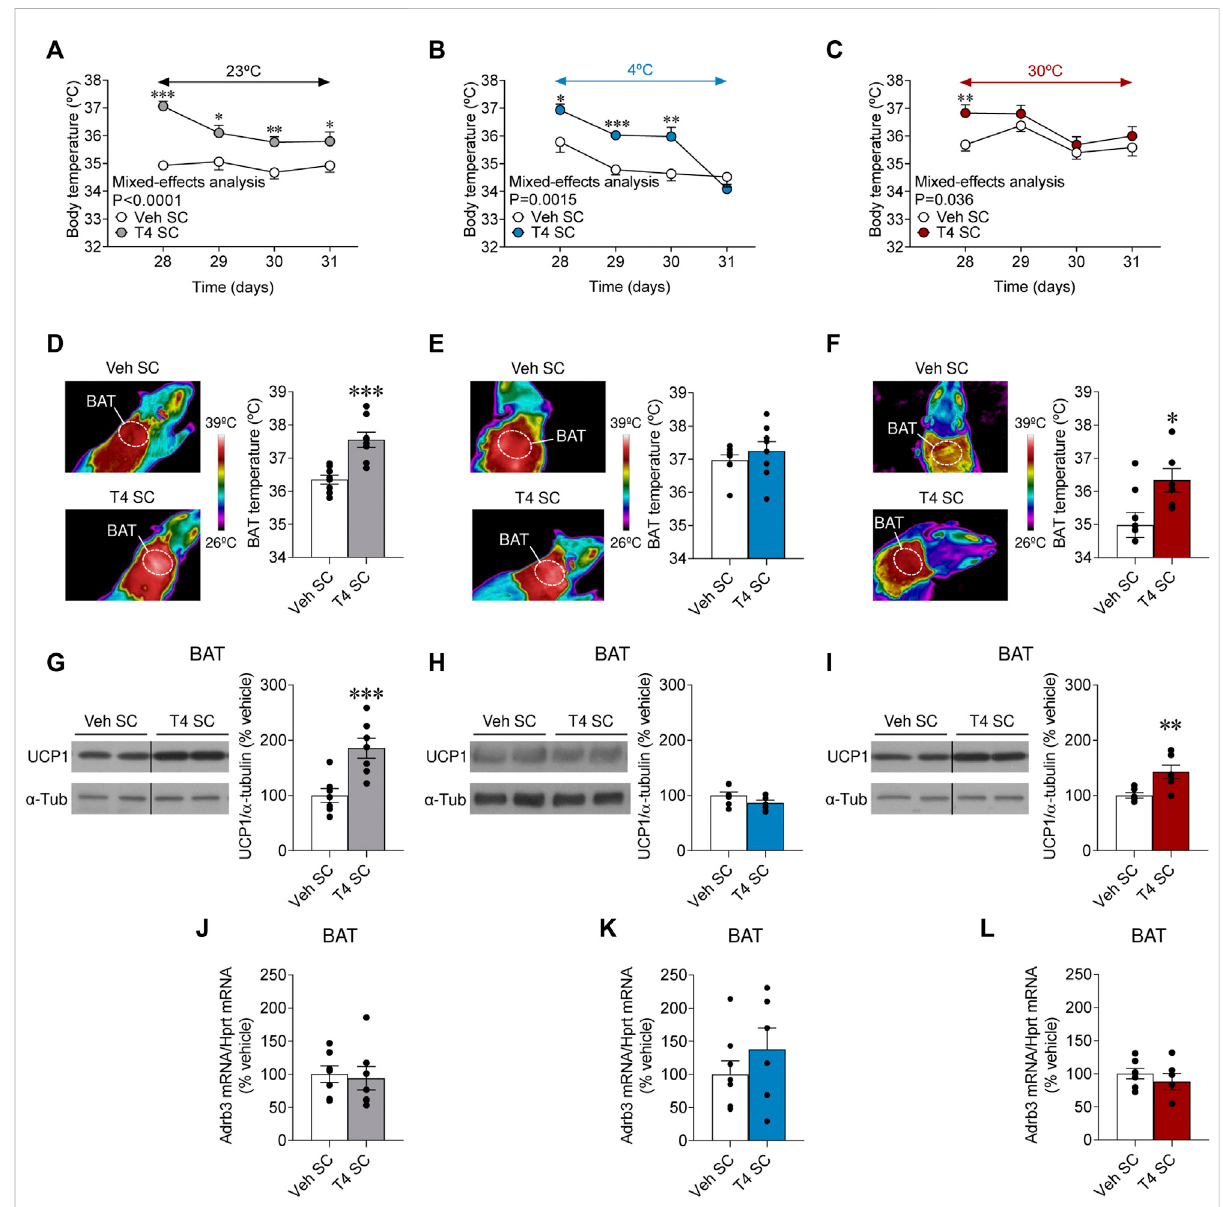
FIGURE 3 Effects of temperature on BAT thermogenesis in hyperthyroid rats (A – C) Body temperature, (D – F) BAT temperature, (G – I) UCP1 protein levels in BAT, and (J – L) Adrb3 mRNA levels in BAT of euthyroid and hyperthyroid rats housed at 23 ° C (A,D,G,J) , 4 ° C (B,E,H,K) or 30 ° C (C,F,I,L) . Data are represented as MEAN ± SEM. n = 6 – 8 rats/group. Statistical signi fi cance was determined by Mixed effect analysis or Student ’ s t -test. * p < 0.05, ** p < 0.01, *** p < 0.001 vs. vehicle